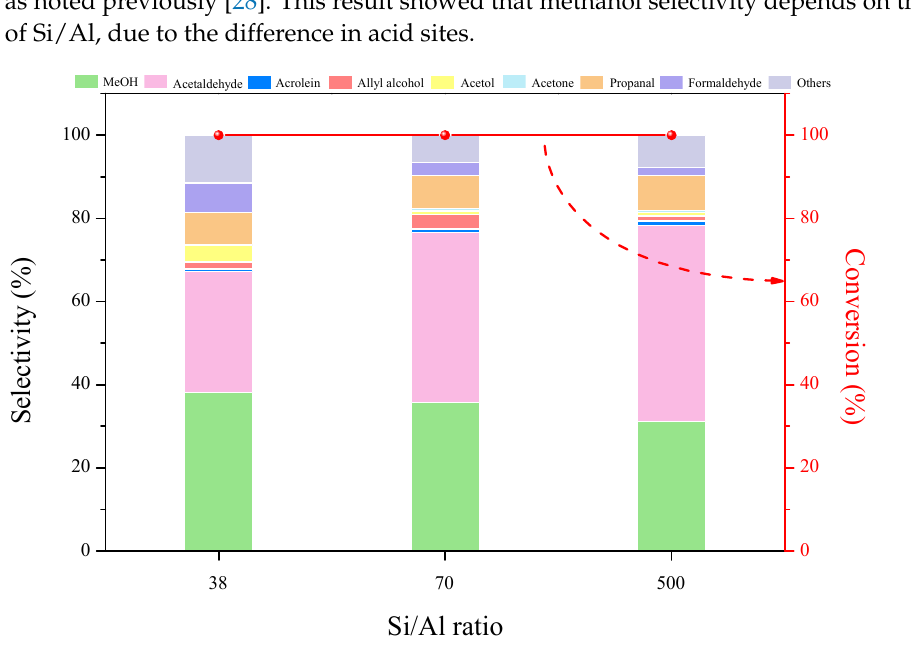
Figure 6. Glycerol conversion and products selectivity over 10%CaO/HZSM-5 catalysts with Si/Al ratio of 38, 70 and 500. Reaction conditions: T = 340 °C, feed flow = 0.03 mL min − 1 (15 wt% glycerol/H 2 O), catalyst weight = 0.10 g, inert carrier = 20 mL min − 1 , TOS = 2 h. The effect of weight hour space velocity (WHSV) on product distribution in glycerol conversion under reaction conditions of 340 °C, 1 bar, and N 2 gas flow rate = 20 mL min − 1